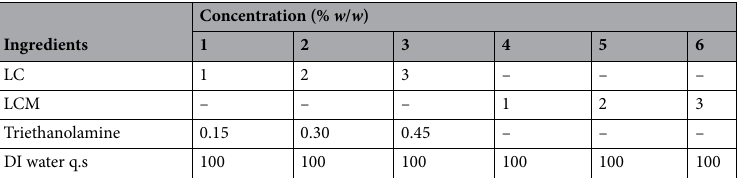
Table 5. Formulations of LLCs using different types and amounts of surfactants. LC: Runemul TM Favor LC (sucrose stearate, cetearyl glucoside, and cetyl alcohol); LCM: Liquid Crystal Cream Maker (sorbitan stearate and sucrose cocoate). Formulations 1–3 used LC at concentrations ranging from 1 to 3% w / w , while Formulations 4–6 used LCM at concentrations ranging from 1 to 3% w / w.